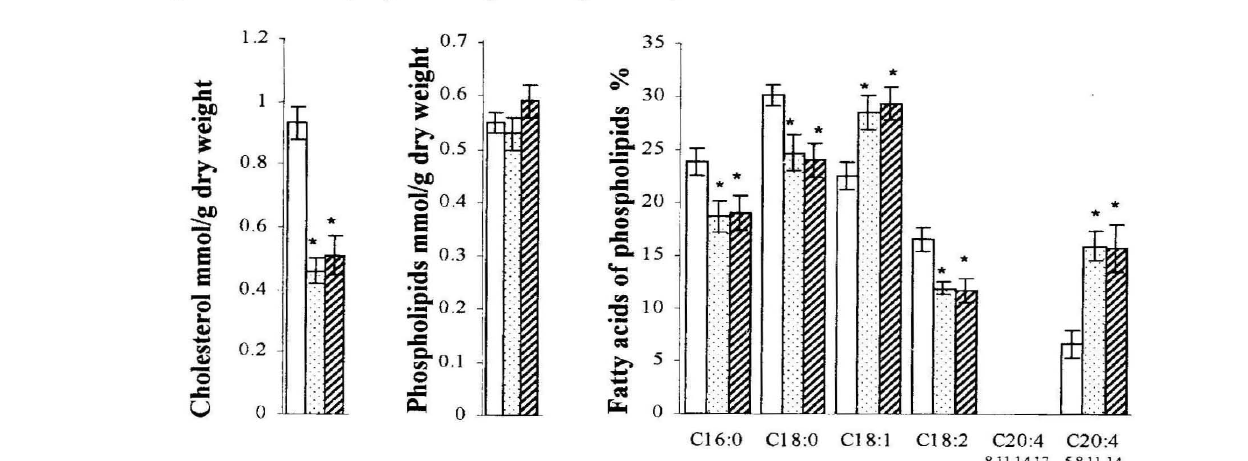
Figure 5. Concentrations (mean±S.D.) of cholesterol and phospholipids as well as fatty acid content of phospholipids (in percent; 111ean±S.D.) in controls (open bars) and in samples with 0.2 nmol/g wet weight nicotinic acid (dotted bars) and in samples with 20 nmoljg wet weight nicotinic acid (hatched bars). Samples of rat liver tissue homogenates were used to test tc)r phospholipid biosynthesis in vitro. Incubation medilun: Krebs - Ringer - phosphate buffer containing 0.3% albumin (pH= 7.4), fatty acid mixture and glvceroL Samples were incub~1ted twice for 4 h at 37"C. *The changes are statistically significant (p<0.05 -p < O.OOI